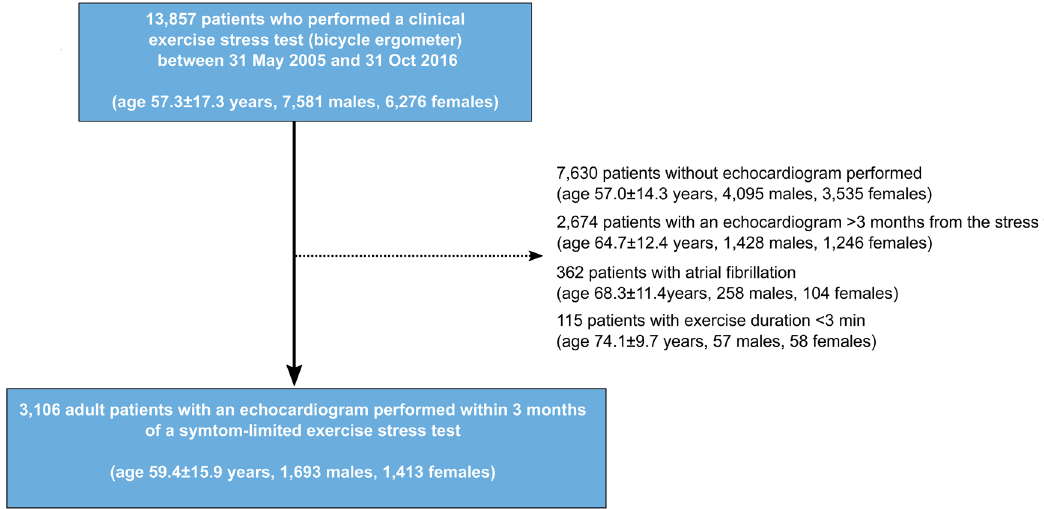
Figure 1. Flow chart of patient inclusion and